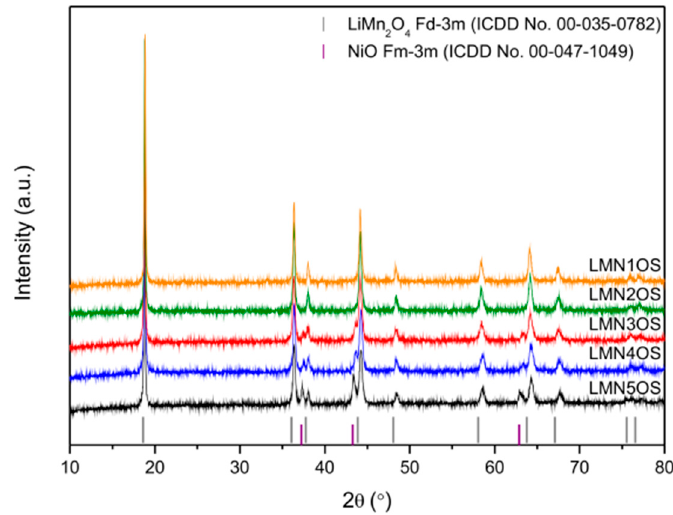
Figure 1. X-ray diffraction patterns of LiMn 2 ´ x Ni x O 3.99 S 0.01 spinels calcined at 650 ˝ C. Table 1. Chemical composition, lattice constant, average crystallites size, and textural properties of